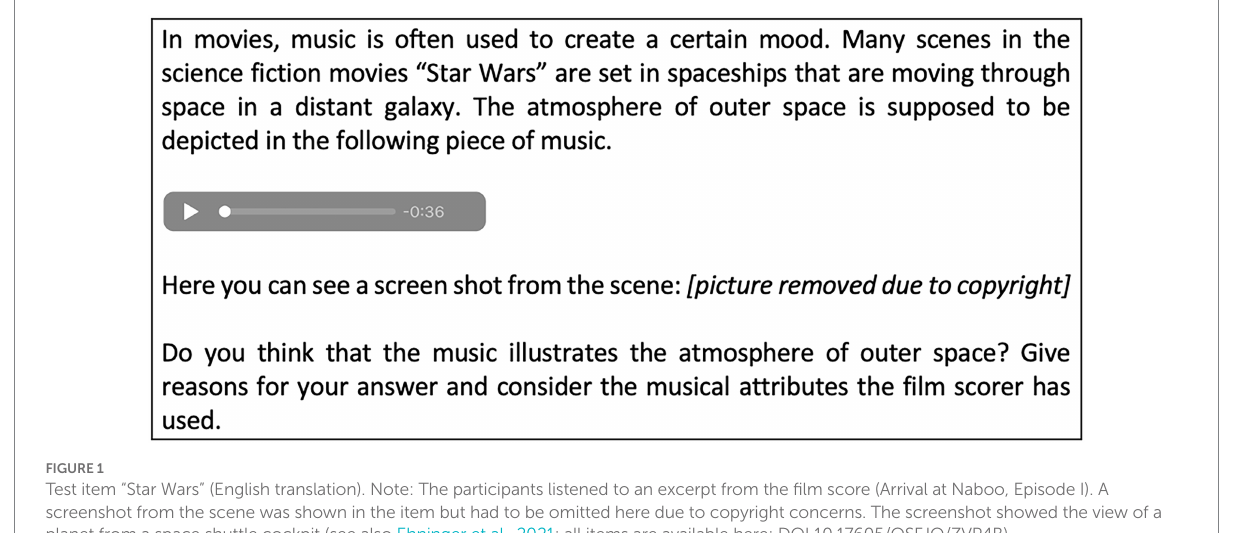
FIGURE 1 Test item “Star Wars” (English translation). Note: The participants listened to an excerpt from the film score (Arrival at Naboo, Episode I). A screenshot from the scene was shown in the item but had to be omitted here due to copyright concerns. The screenshot showed the view of a planet from a space shuttle cockpit (see also Ehninger et al., 2021; all items are available here: DOI